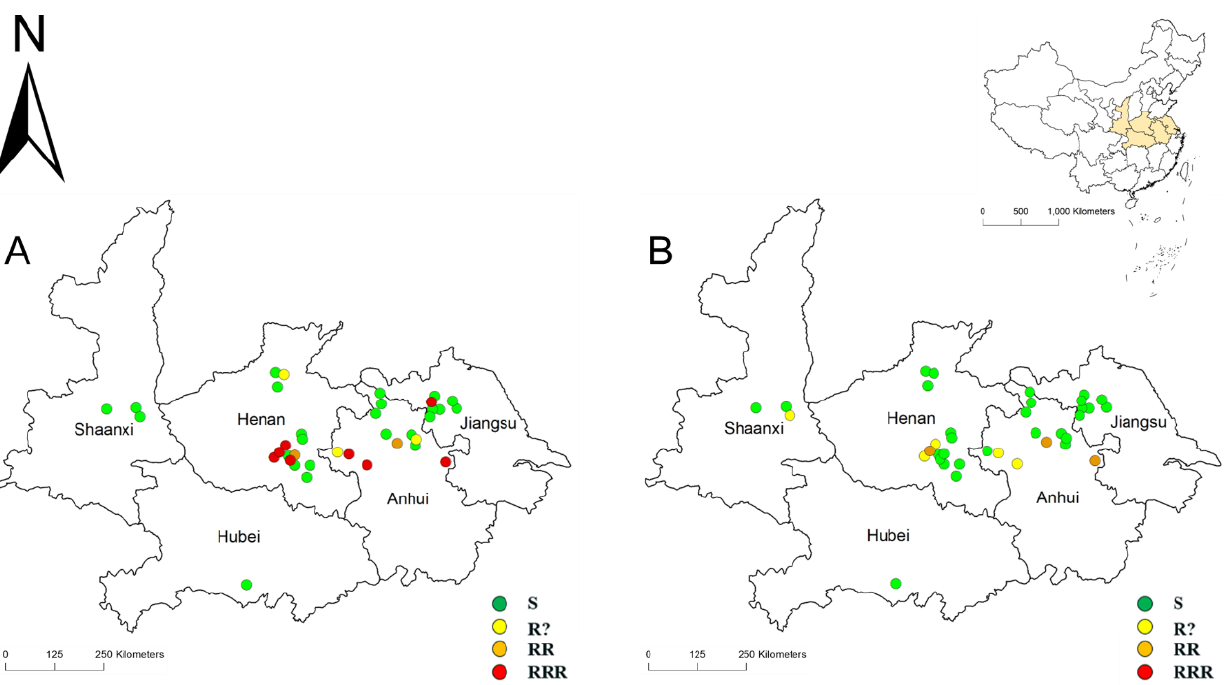
Figure 1. The distribution of 37 L. multiflorum populations collected from the Huang-Huai-Hai Plain, China. The susceptibility of different populations to clodinafop-propargyl ( A ) and mesosulfuron- methyl ( B ) was classified according the “R” rating system. RRR means resistance confirmed, highly likely to reduce herbicide performance; RR means resistance confirmed, probably reducing herbicide performance; R? means early indications that resistance may be developing, possibly reducing herbicide performance; and S means